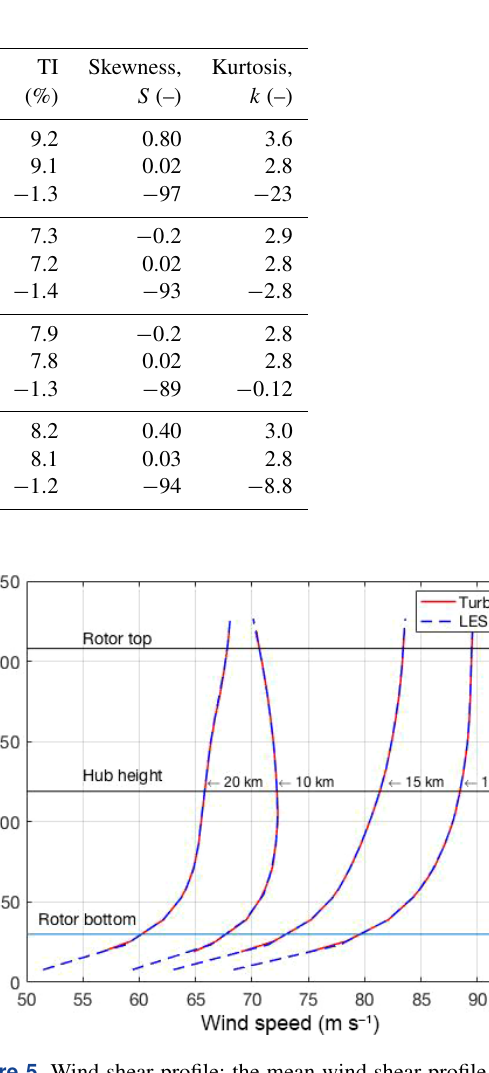
Figure 5. Wind shear profile: the mean wind shear profile at R = 10, 12, 15, and 20km for both the LES and TurbSim wind field simulations. For reference, the three horizontal lines indicate the top and bottom of the rotor disk at 208 and 30m, respectively, and the hub height at